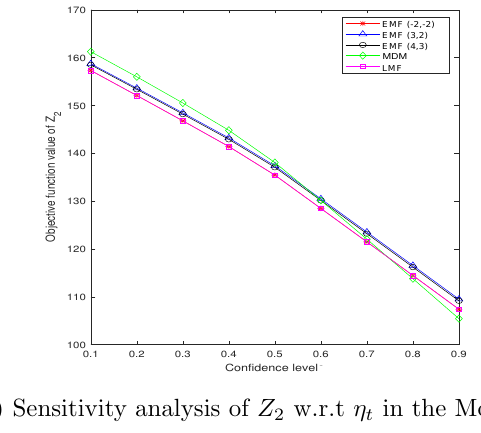
(b) Sensitivity analysis of Z 2 w.r.t η t in the Model-6. Figure 3. The sensitivity analysis of the objectives in OV Model-6 w.r.t η t using FPT and